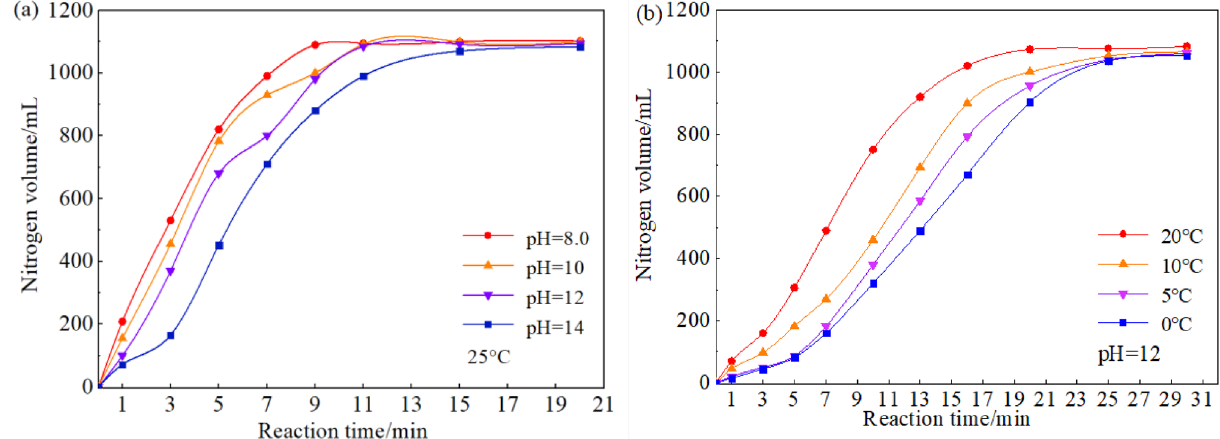
Figure 2. Effect of different conditions on nitrogen gas volume: ( a ) pH; ( b )